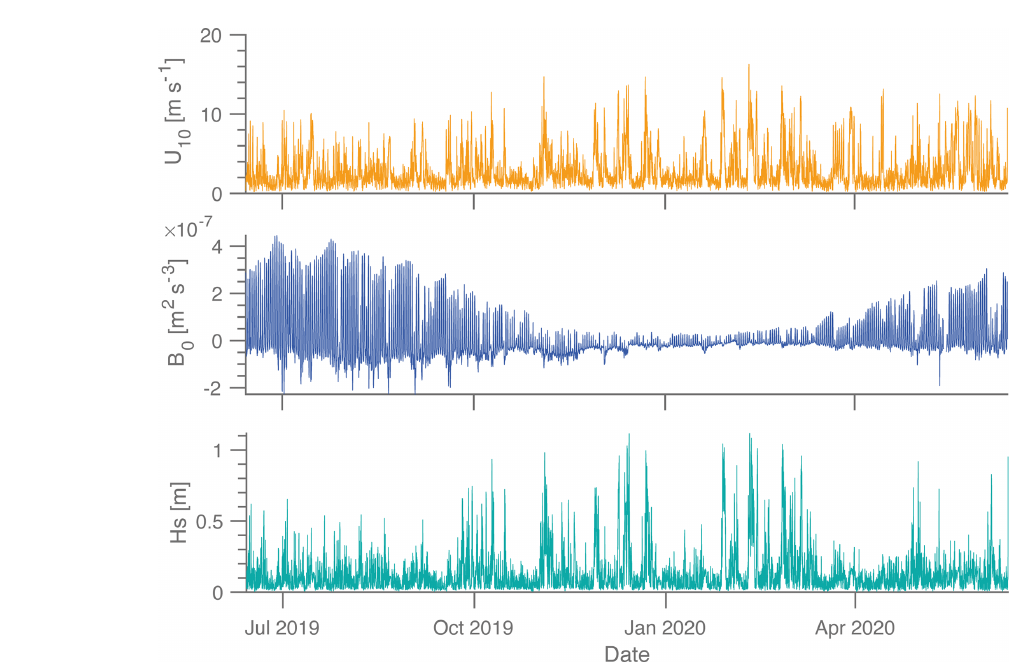
Figure C1. Annual evolution of three main inputs of k models: wind speed at 10m ( U 10 ), buoyancy flux at surface ( B 0 ), and significant wave height ( H s